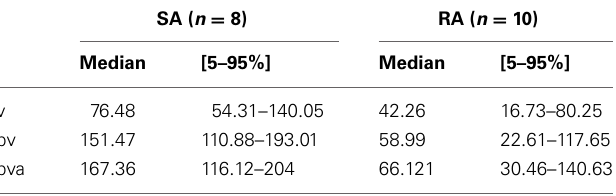
kinematic parameters of whisker deflection.